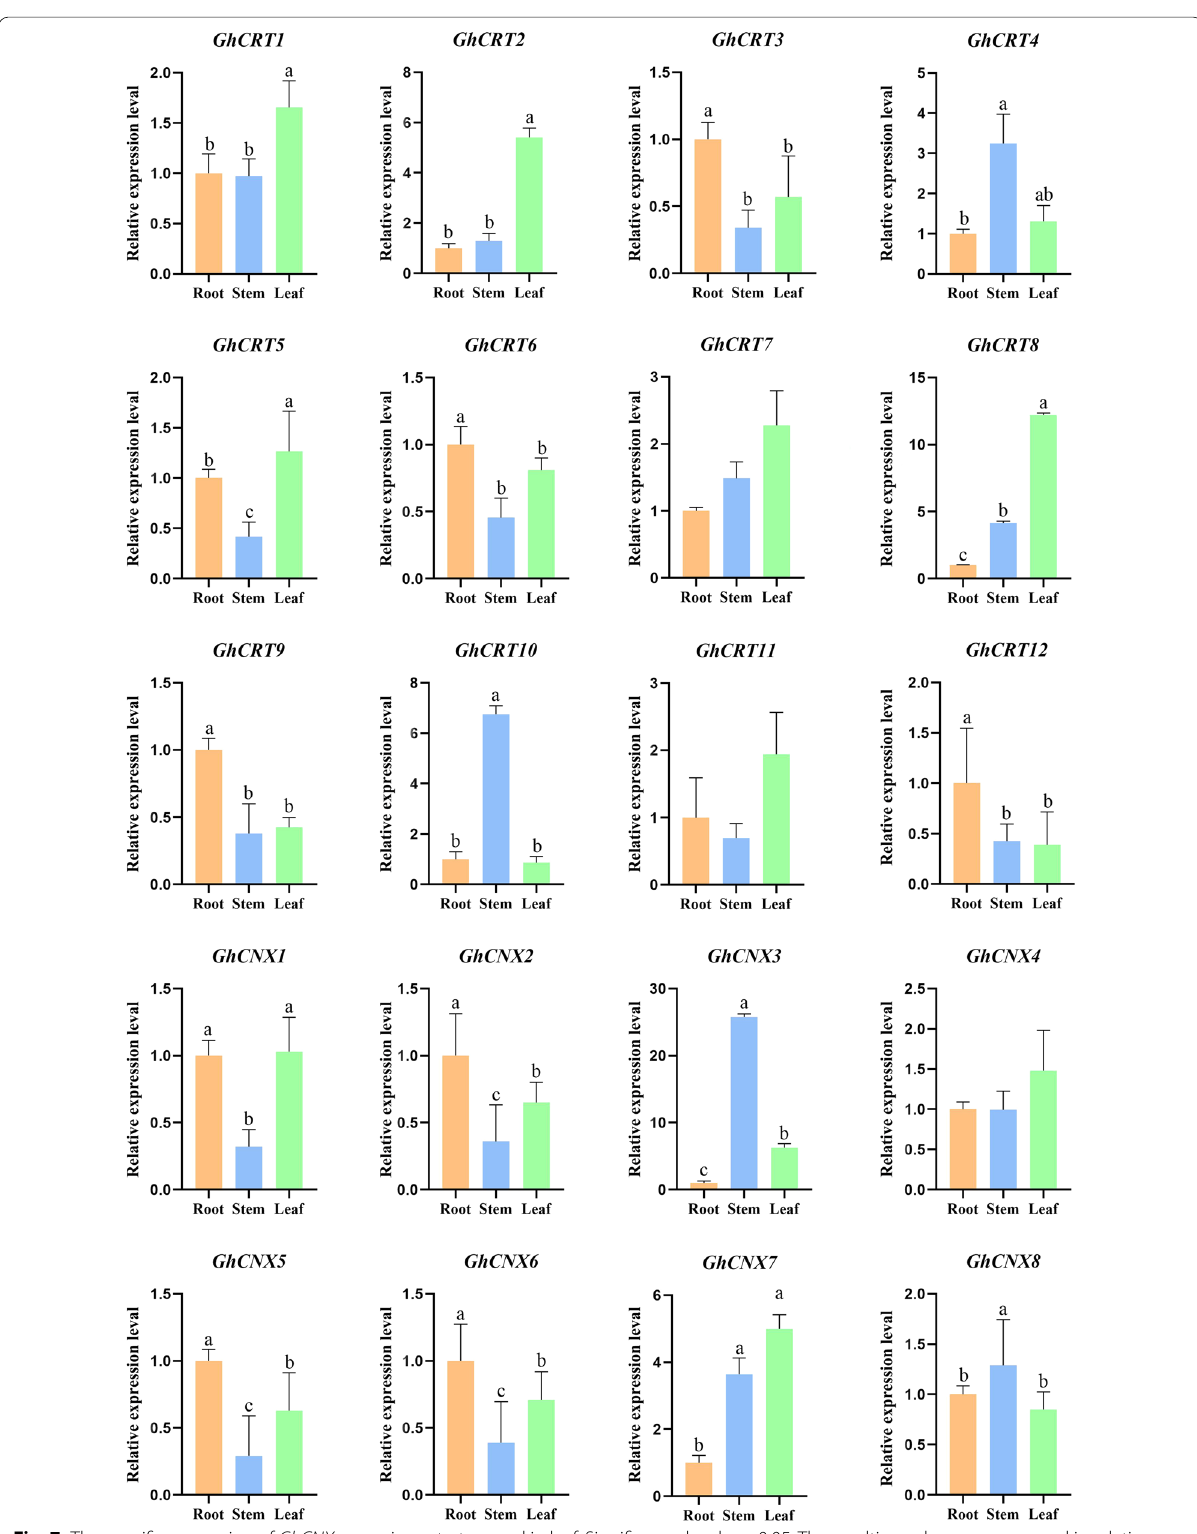
Fig. 7 The specific expression of GhCNX genes in root, stem and in leaf. Significance level α units. The error bar in the figure is the standard deviation (SD) of the three biological replicates in each treatment